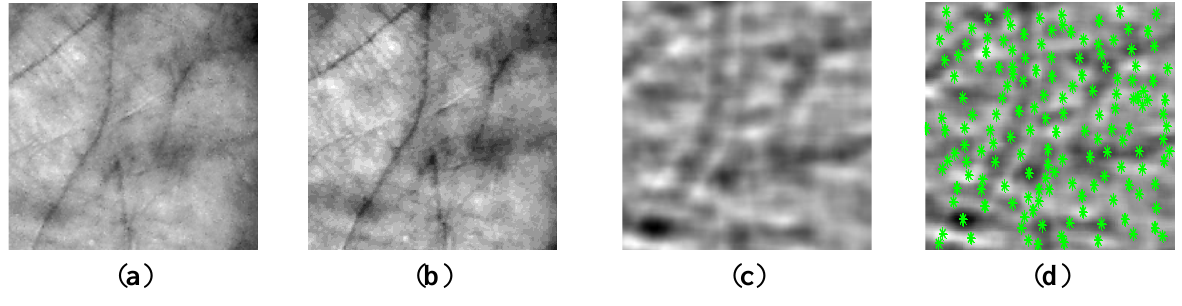
Figure 15. Original palmprint image ( a ); contrast limited adaptive histogram